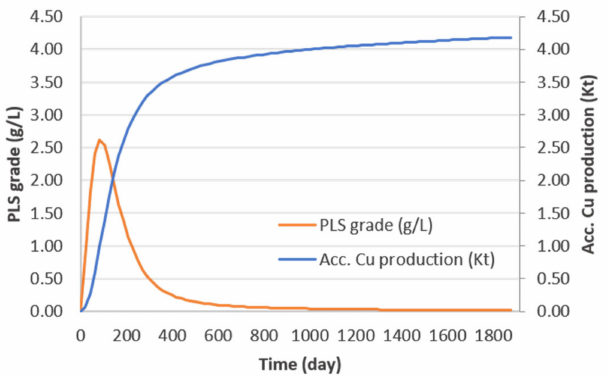
Figure 25. The predicted PLS grade and accumulated copper production for the example production scenario for the Kapunda copper ISR